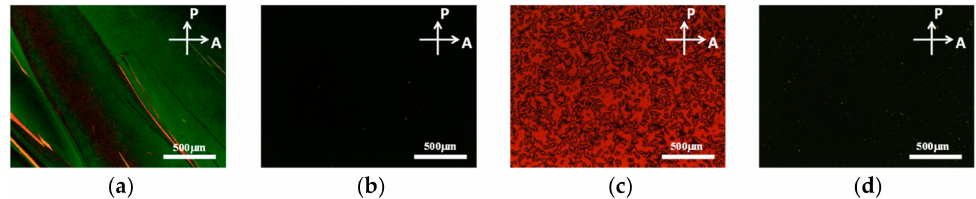
Figure 2. Polarized optical microscopy (POM) images of ( a ) pure liquid crystals (LC) HFW59200-200; ( b ) 0.1 wt %-12-HSA-doped HFW59200-200; ( c ) pure LC E7; and ( d ) 0.1 wt %-12-HSA-doped E7 cells, obtained between crossed polarizers.